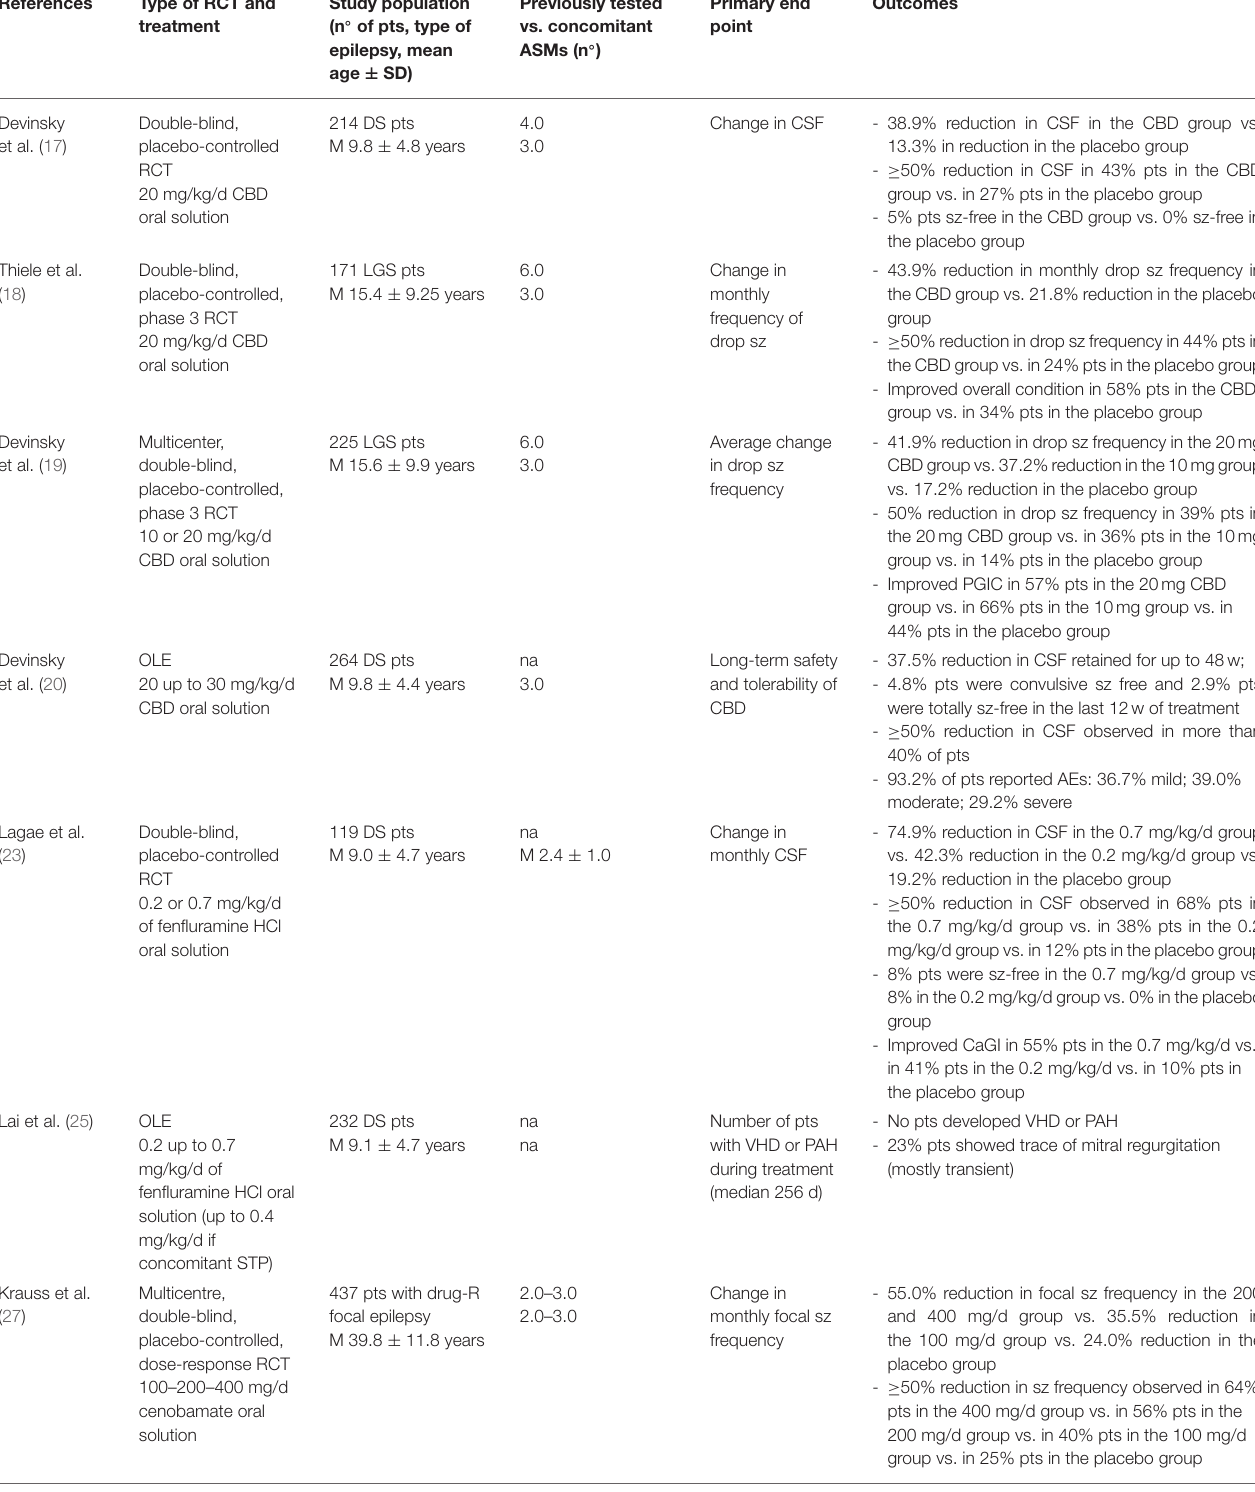
TABLE 1 | Advanced RCTs on new drugs for epilepsy